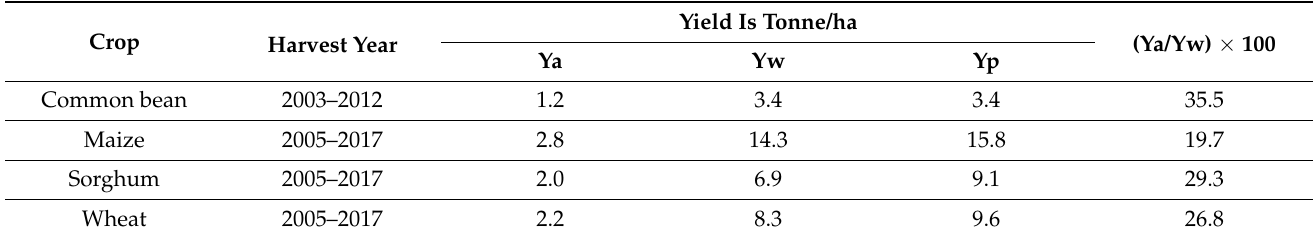
Table 2. Yield potential (Yp), water-limited yield potential (Yw), and actual yield (Ya) of some crops available in Global Yield Gap Atlas for